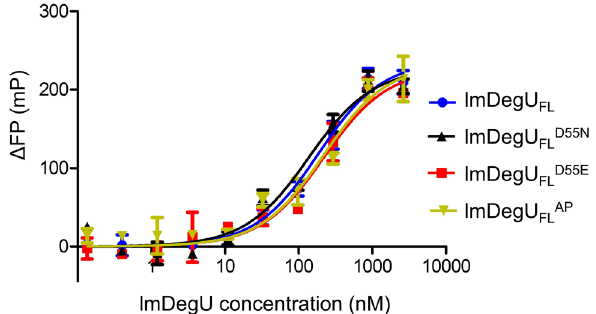
Figure 6. Similar dsDNA-binding levels of lmDegU observed irrespective of phosphorylation. The dsDNA- binding levels of lmDegU FL , phosphorylation-incompatible lmDegU FLD55N , the lmDegU FLD55E phosphomimetic, and acetyl phosphate-phosphorylated lmDegU FL (lmDegU FLAP ) were determined by the FP assay. The data (means ± S.D.) are representative of five independent experiments that yielded similar